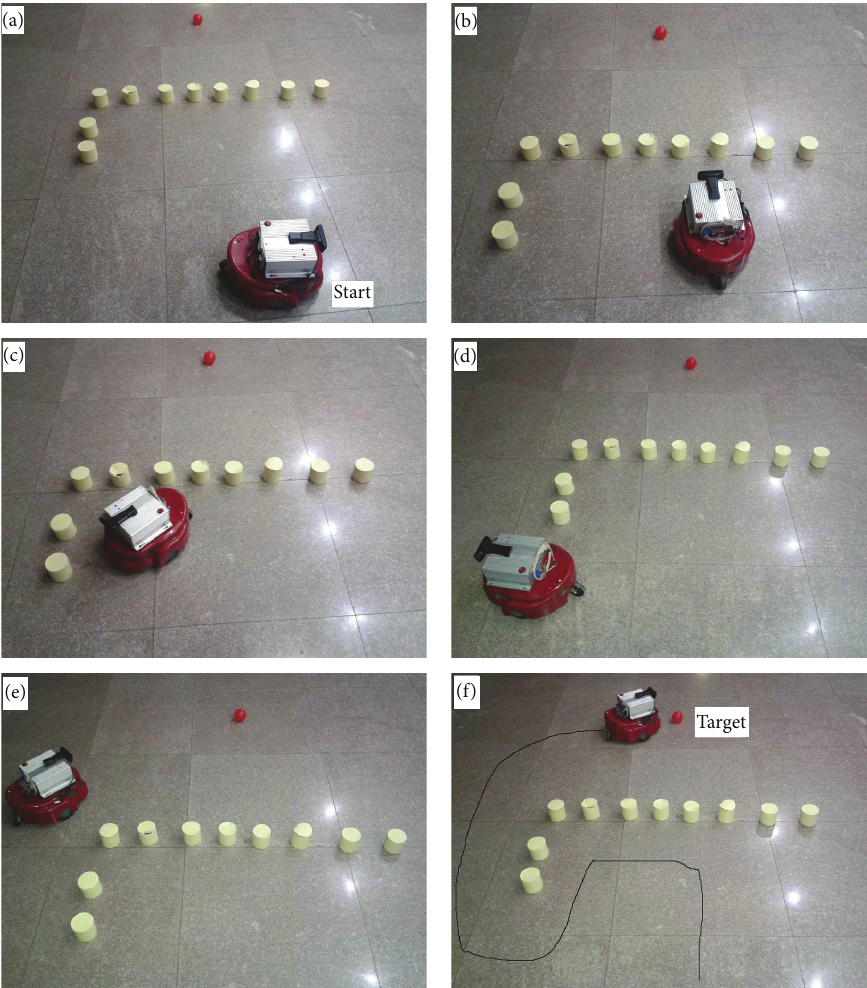
Figure 9: Barrier